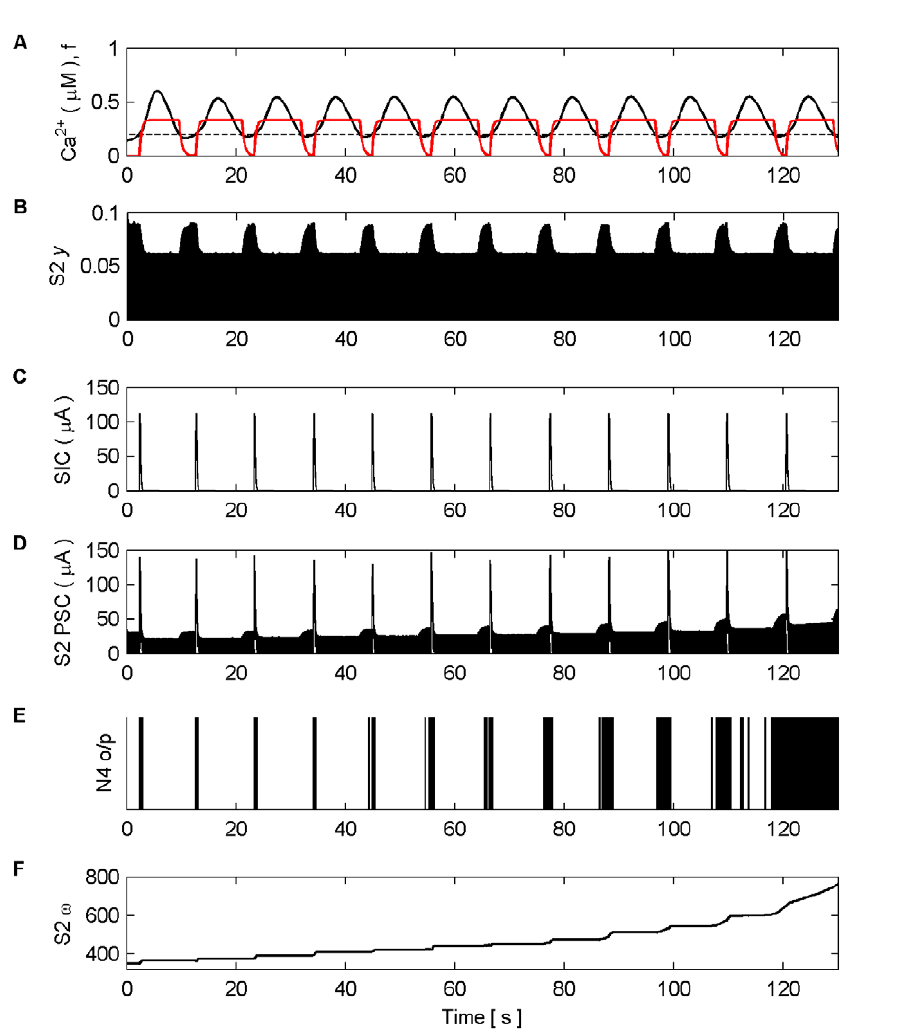
Figure 6. Synaptic Plasticity in the AN Model. (A) Ca 2 + oscillation resulting from pre-synaptic stimulation of S1 by N1, including the gating function f (red) and Ca 2 + threshold (dashed). (B) neurotransmitter ( y ) released by S2 as a result of pre-synaptic stimulation by N2. Note how y is modulated by f due to glutamate release by the astrocyte when Ca 2 + levels cross the threshold from below, targeting and binding with presynaptic mGluRs. (C) NMDA-mediated SICs induced by the release of glutamate from the astrocyte when Ca 2 + levels cross the Ca 2 + threshold. (D) PSC (Post- Synaptic Currents) comprising EPSCs and SICs). The EPSCs in S2 are generated as a result of the neurotransmitter released by S2 scaled by the weight of the synapse ( v ) (see F). (E) N4 output firing activity (o/p). As long as the weight of S2 remains too low, N4 is only capable of firing when the astrocyte induces an NMDA current driven by the ‘supervisory’ input of N1. However this firing promotes STDP by allowing N4 to fire and therefore S2 is potentiated (see F). From , 45 s onward the synapse is strong enough to cause firing also as a result of the pre-synaptic activity of N3. At , 115 s the weight quickly grows uncontrollably and the neuron begins to fire rapidly.